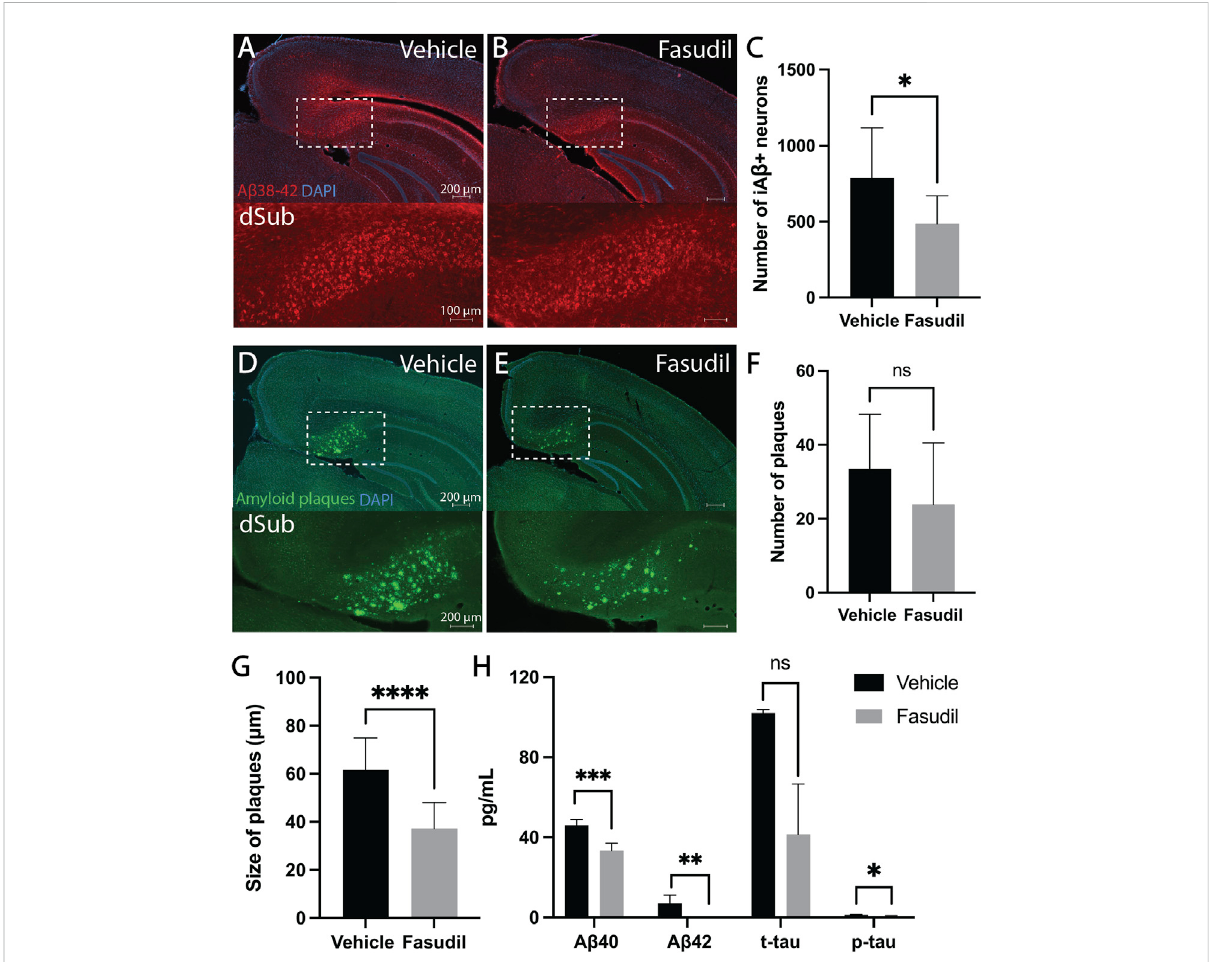
FIGURE 1 Inhibiting the Wnt-PCP pathway attenuated amyloid- β and tau pathology in early and late phase AD. (A) Intraneuronal A β 38-42 (McSA1; red) in dSub in 3xTg AD mice ( n = 4) receiving infusions of a vehicle (i.e., saline). DAPI counterstain (blue). (B) A β 38-42 (McSA1; red) immunoreactivity in dSub in 3xTg AD mice ( n = 6) receiving infusions of Fasudil. DAPI counterstain (blue). (C) Mean number of A β + neurons in dSub of 3xTg AD mice after infusions of a vehicle and Fasudil. Intraneuronal A β in dSub was quanti fi ed from at least 7 brain sections for each animal using Ilastik. Error bars denote ±1 SD, unpaired two-tailed t -test, * p < 0.05. (D) Amyloid plaques (amyloid fi brils OC; green) in dSub of 3xTg AD mice ( n = 2) receiving infusions of a vehicle. DAPI counterstain (blue). (E) Amyloid plaques (amyloid fi brils OC; green) in dSub of 3xTg AD mice ( n = 4) receiving infusions of Fasudil. DAPI counterstain (blue). (F) Mean number of amyloid plaques in dSub of 3xTg AD mice after infusions of a vehicle and Fasudil. Amyloid plaques in dSub were quanti fi ed from at least 4 brain sections for each animal using Ilastik. Error bars denote ±1 SD, unpaired two-tailed t -test, n. s. non-signi fi cant. (G) Mean size of amyloid plaques in dSub of 3xTg AD mice after infusions of a vehicle and Fasudil. Amyloid plaques in dSub were quanti fi ed from at least 4 brain sections for each animal using Ilastik. Error bars denote ±1 SD, unpaired two-tailed t -test, ****: p < 0.0001. (H) Mean concentrations of duplicates of A β 40 , A β 42 , p-tau and t-tau CSF levels (pg/ml) as measured by multiplex ELISA on the last day of infusion (day 14) of a vehicle ( n = 6) or Fasudil ( n = 10)in young and older 3xTg AD mice. Error barsdenote ±1SD, unpaired two-tailed t -test, ***: p < 0.001, **: p < 0.01,